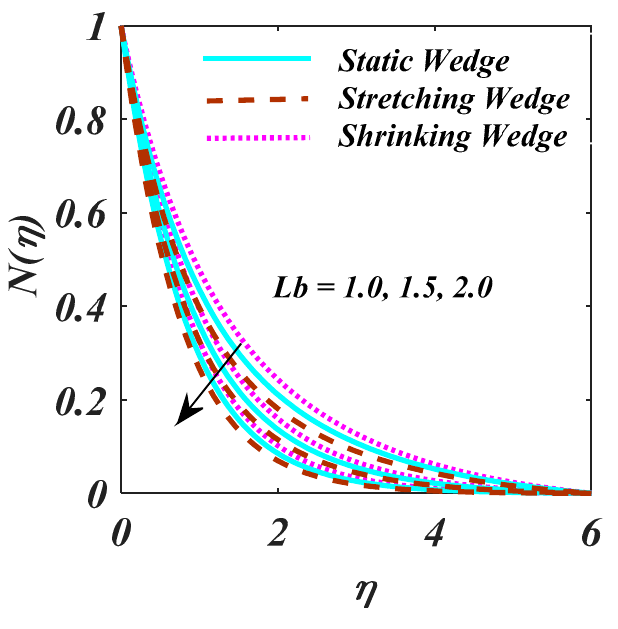
Figure 10. Plot of (cid:1838)(cid:1854) on (cid:1840)(cid:4666)(cid:2015)(cid:4667). Figure 10. Plot of Lb on N ( η )